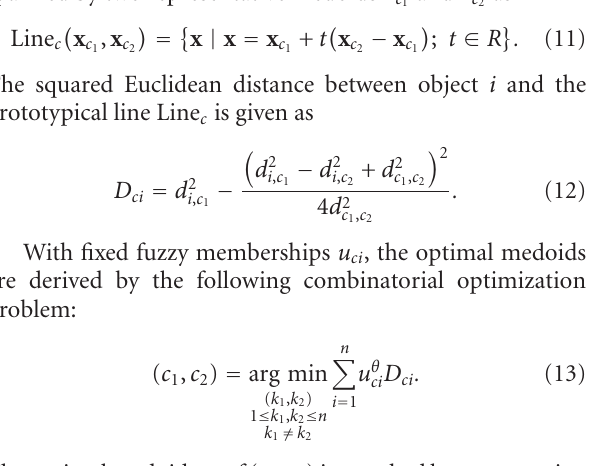
Figure 1: 2D plots of artificial data